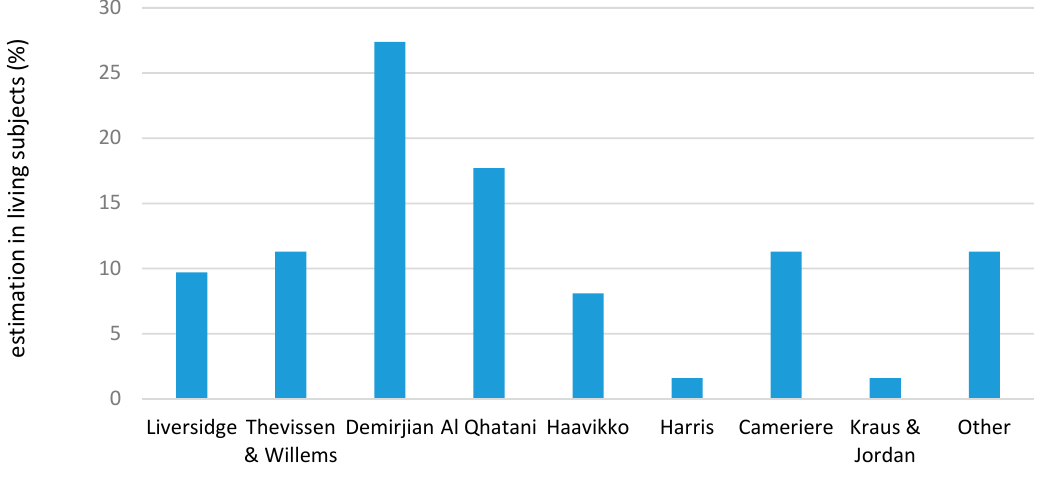
Figure 5. Types of methods used for age estimation in living subjects (%).